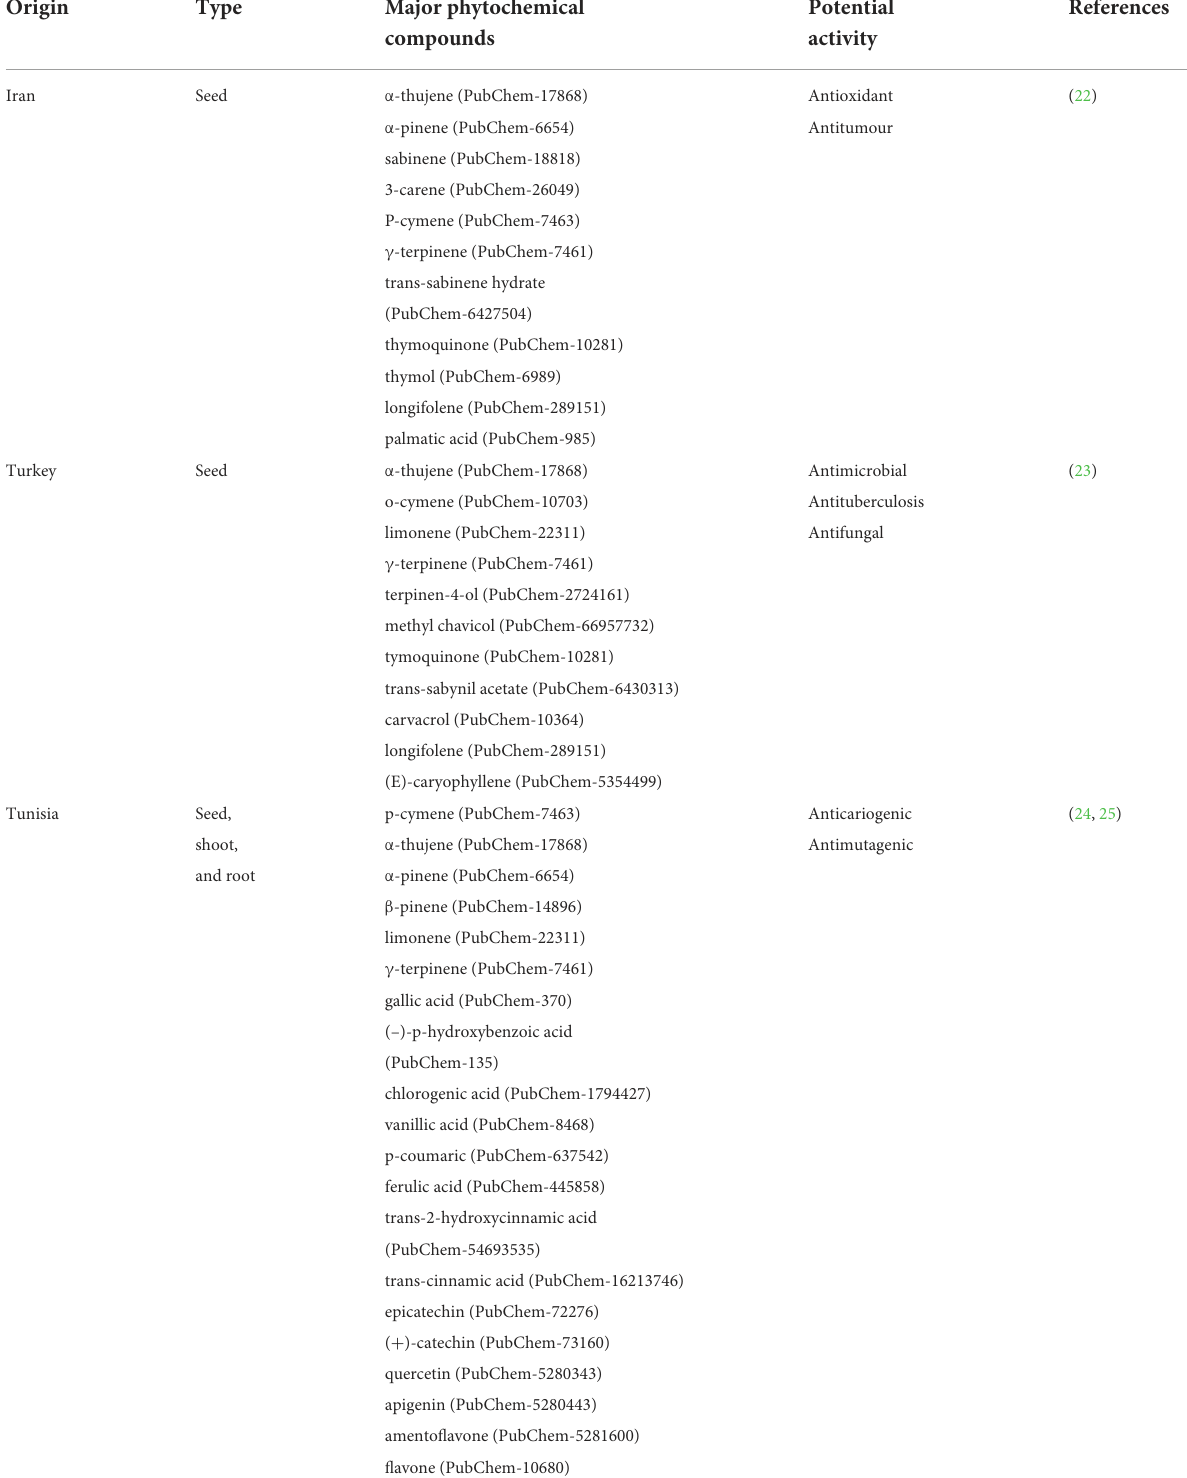
TABLE 1 Phytochemical compounds of NS from different